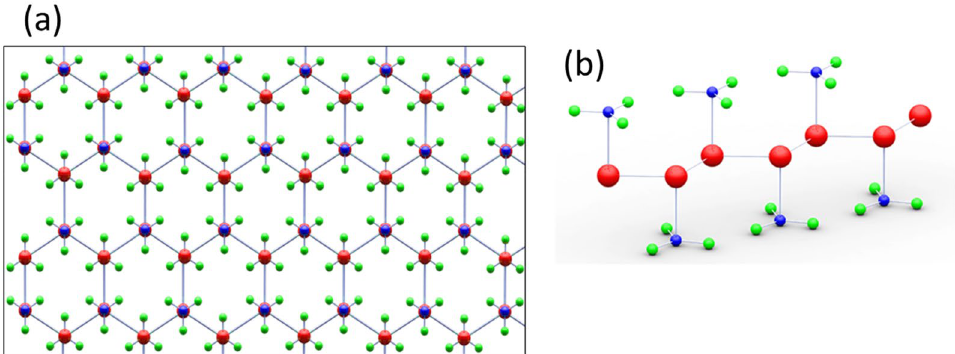
Figure 1. Graphic of ( a ) top and ( b ) side views of the GeCH 3 SL structure atomic.